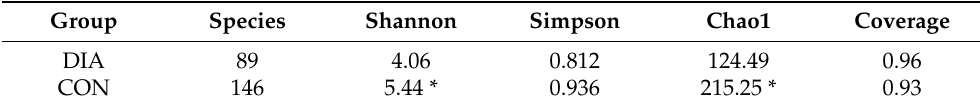
Table 1. Alpha diversity analysis of intestinal microbial of rabbit colon. The notation * indicate significant differences ( p < 0.05) among groups.